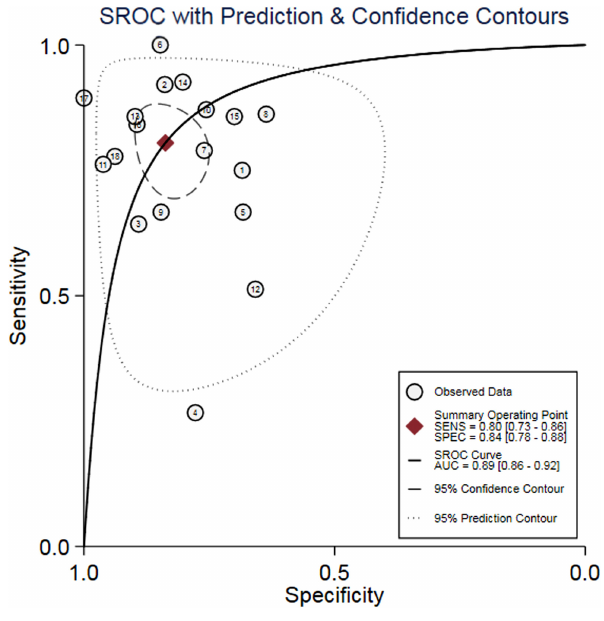
Figure 4. Summary of receiver operating characteristic curve for the accuracy of procalcitonin in the diagnosis of SAP. SAP, severe acute pancreatitis.